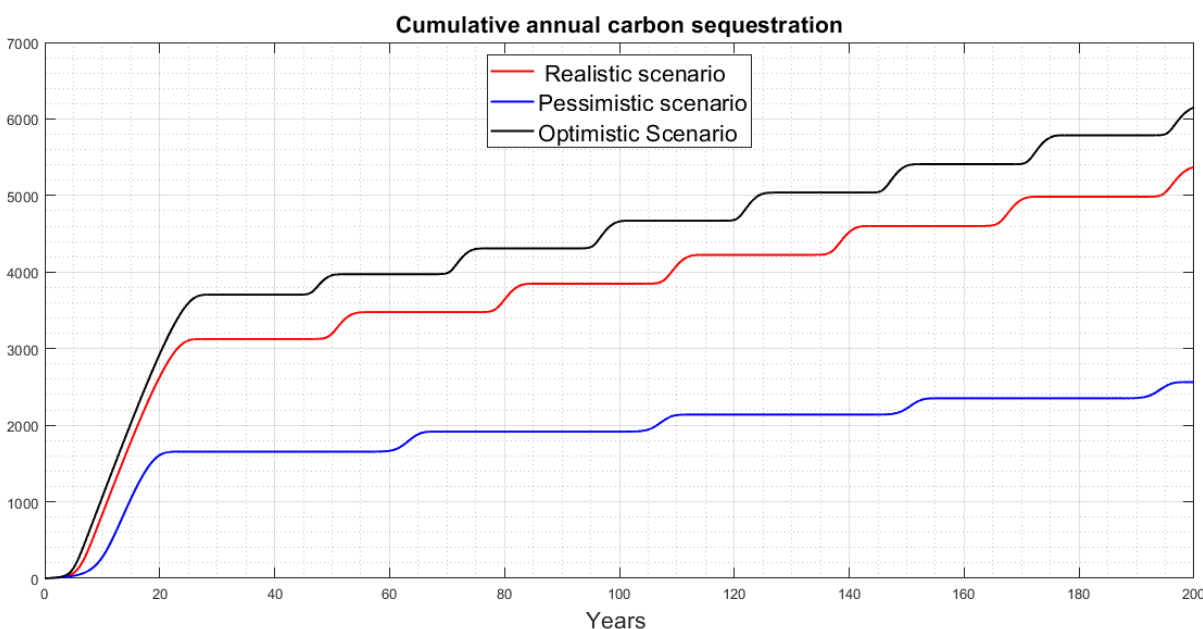
Figure 2. Optimal state trajectories for living biomass, intrinsic growth, burned area, and carbon capture for the three scenarios: (a) represents the dynamics of living biomass, (b) represents carbon sequestration, (c) represents the dynamics of burned area, and (d) represents intrinsic growth.